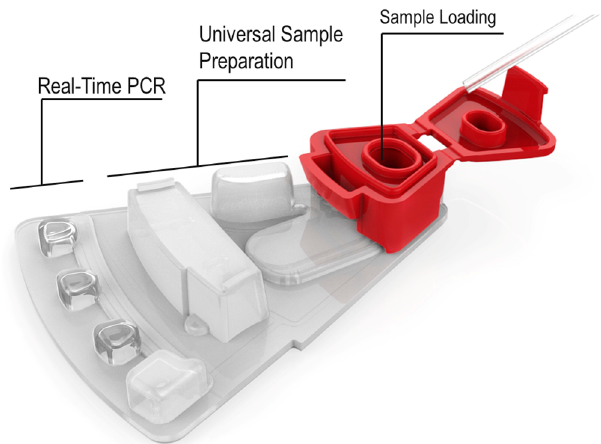
Figure 1. Schematic description of the GenePOC disposable, a MCD integrating the essential functions and components for performing nucleic acid-based diagnostics at POC. Copyright © GenePOC Inc. 2016 All rights reserved.